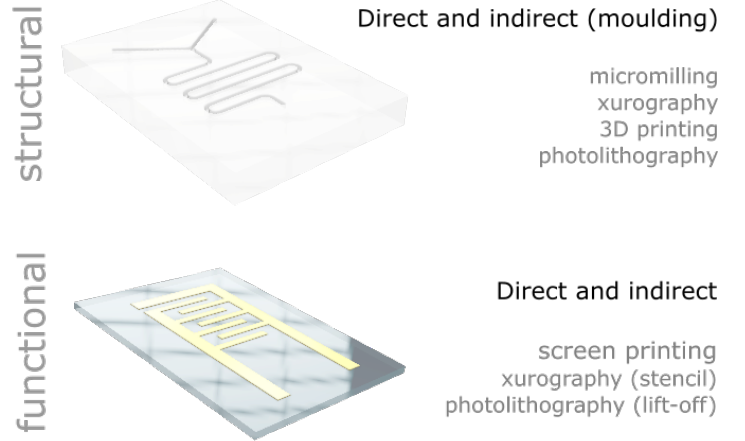
Figure 1. Overview of the low-cost processes presented in the manuscript for the structuring of structural and functional material with feature sizes below 1 mm.